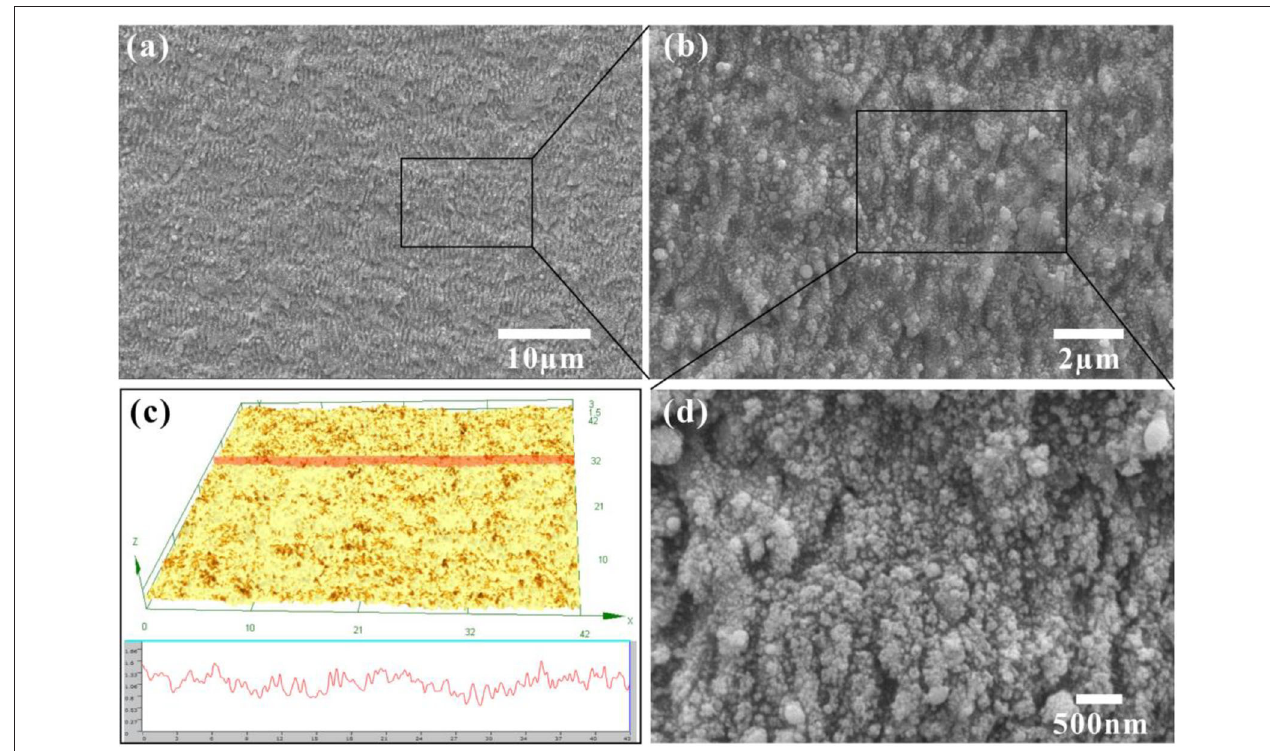
FIGURE 1 | Morphology of the iron surface after femtosecond laser ablation. (a,b,d) SEM images of the laser-ablated surface. (c) Laser confocal microscopy image of the laser-ablated surface.